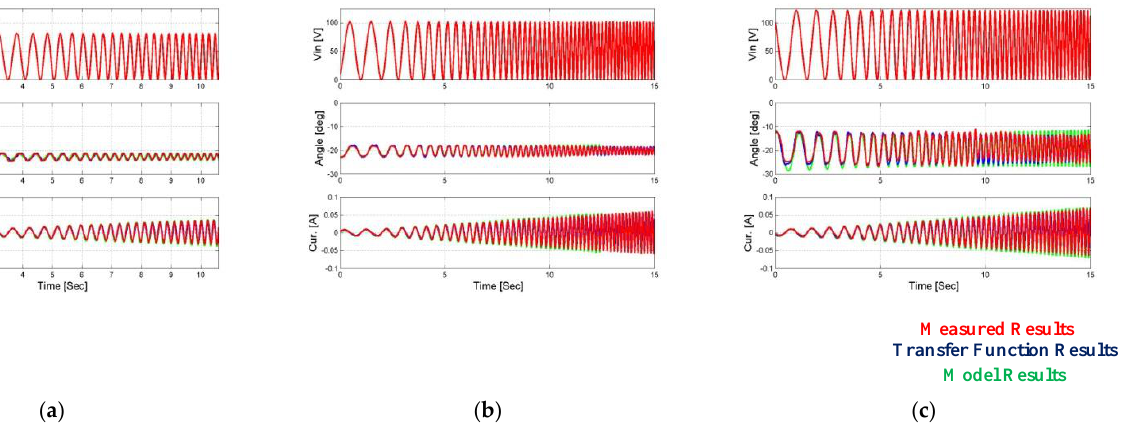
Figure 18. Comparison of uniform transfer function results ’ model results vs. measured output results when the first load is applied. ( a ) Vin = 80 V, ( b ) Vin = 100 V, and ( c ) Vin = 120 V.